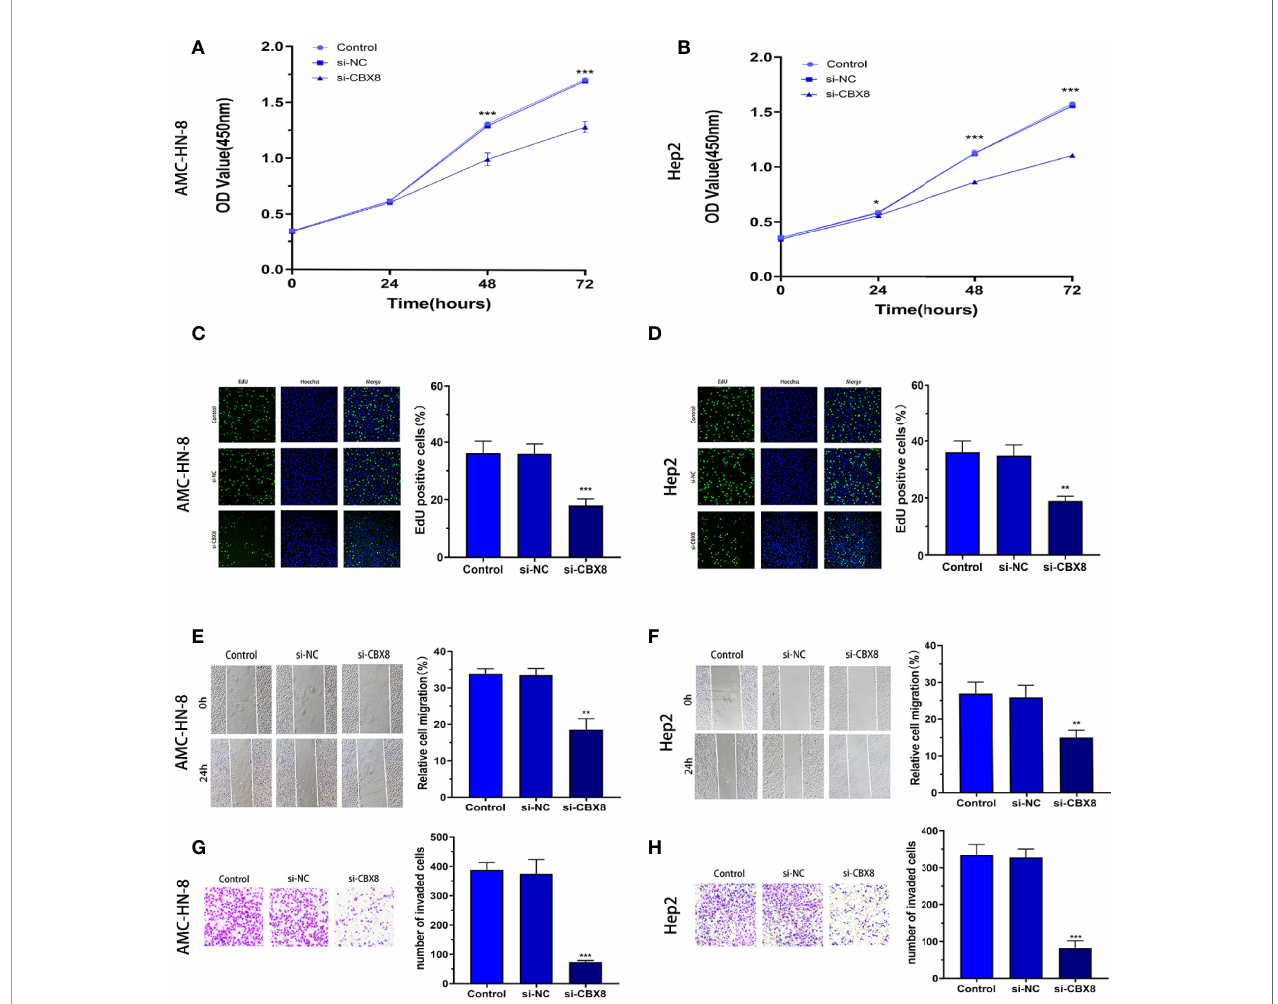
FIGURE 3 | Knockdown of CBX8 inhibited LSCC cell proliferation, migration and invasion. (A, B) A CCK-8 assay was used to detect the effect of CBX8 on the proliferation of LSCC cells. (C, D) The effect of CBX8 on the proliferation of LSCC was detected by EdU assay. (E, F) The effect of CBX8 on the migration of LSCC cells was detected by wound healing assay. (G, H) Transwell assays were used to detect the effect of CBX8 on the invasion of LSCC cells (crystal violet staining ×200). Each assay was repeated at least three times. Data from one representative experiment is presented as Mean ± SEM (**P < 0.01, ***P <